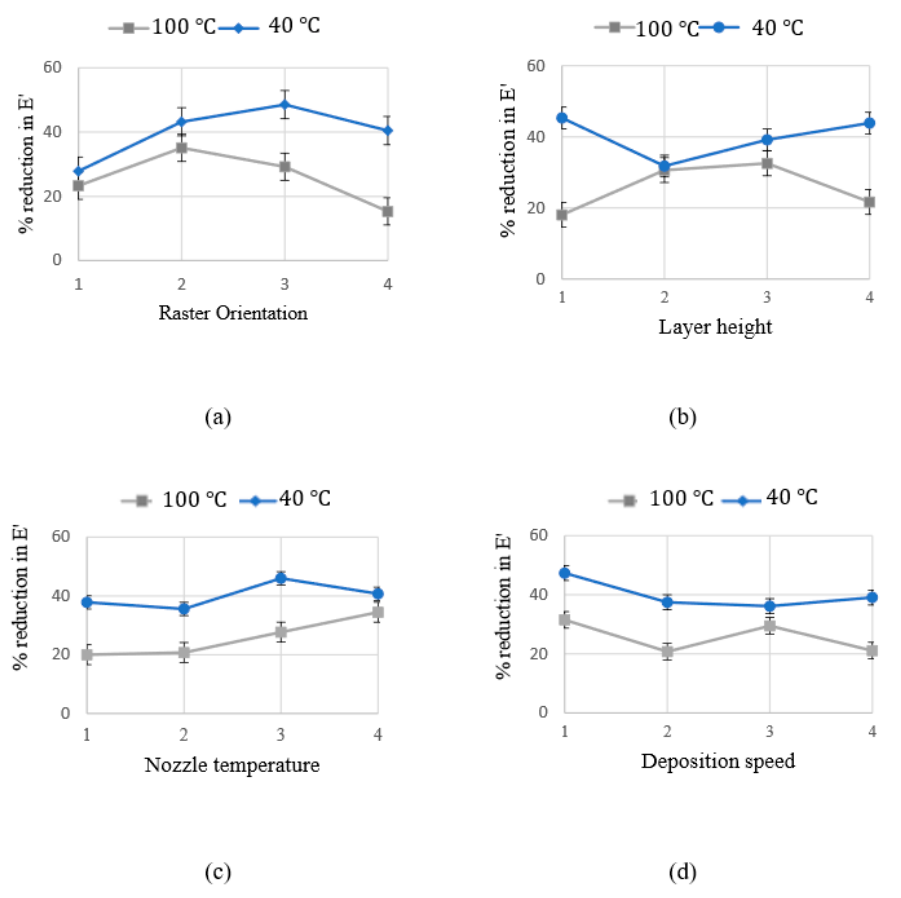
Figure 8. Percentage of reduction in storage modulus as a function of FDM process parameters: ( a ) Raster orientation; ( b ) Layer height; ( c ) Nozzle temperature; ( d ) Deposition speed. The blue and the grey lines represent the average reduction in the storage modulus at 40 ℃ and 100 ℃ respectively.